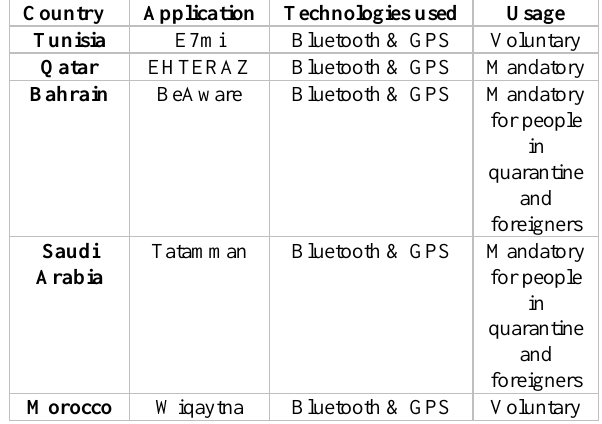
Table 1 : Covid-19 Tracking